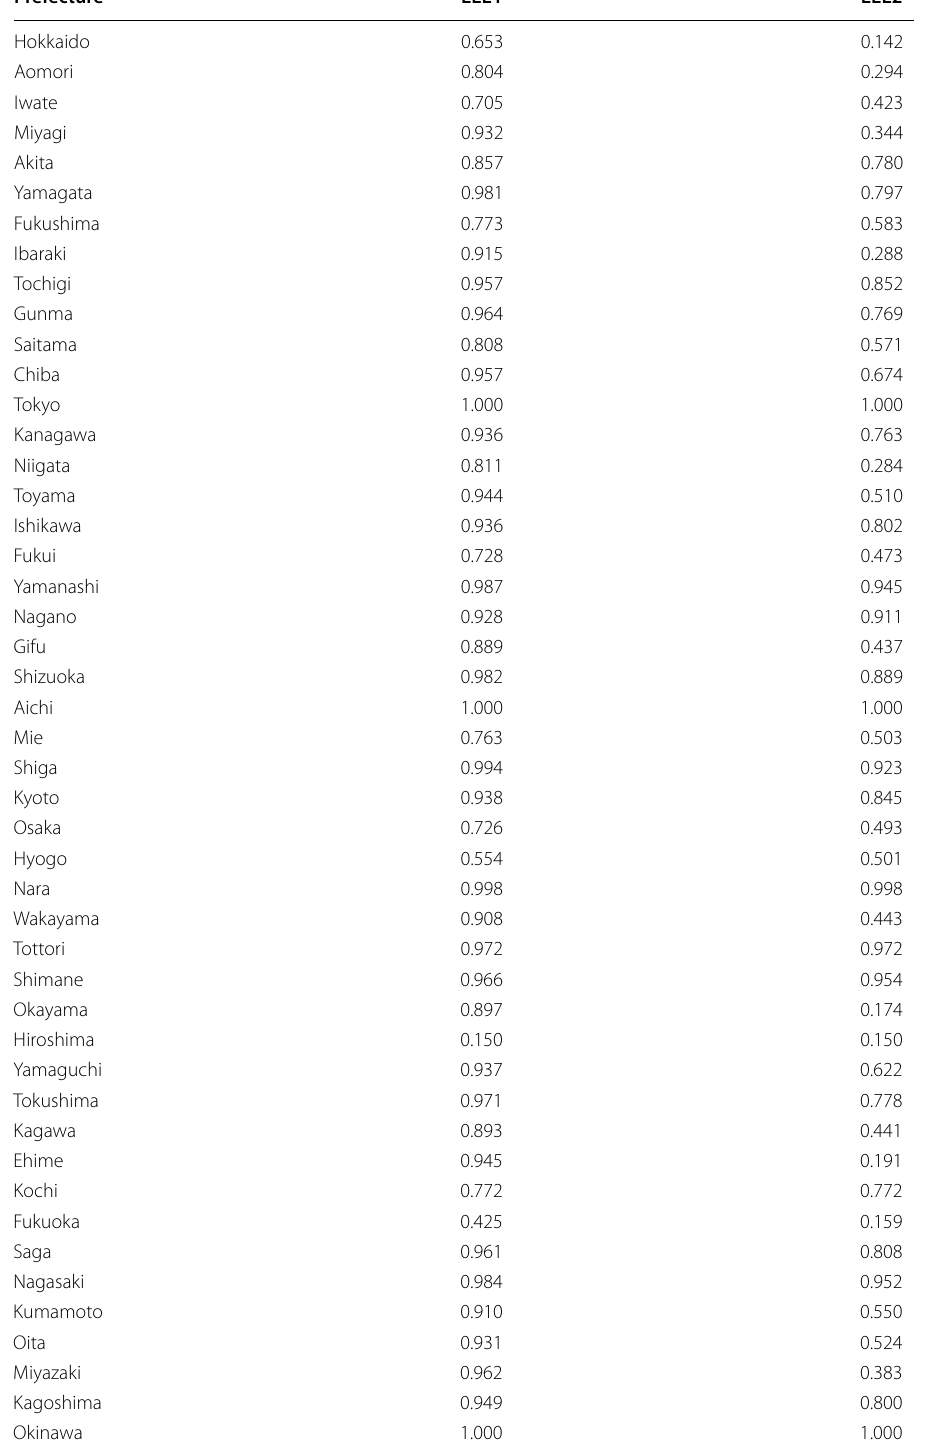
Table 2 Annual mean of EEE1 and EEE2 for the manufacturing sector by prefecture (1990–2012) Prefecture EEE1 EEE2 Hokkaido 0.653 0.142 Aomori 0.804